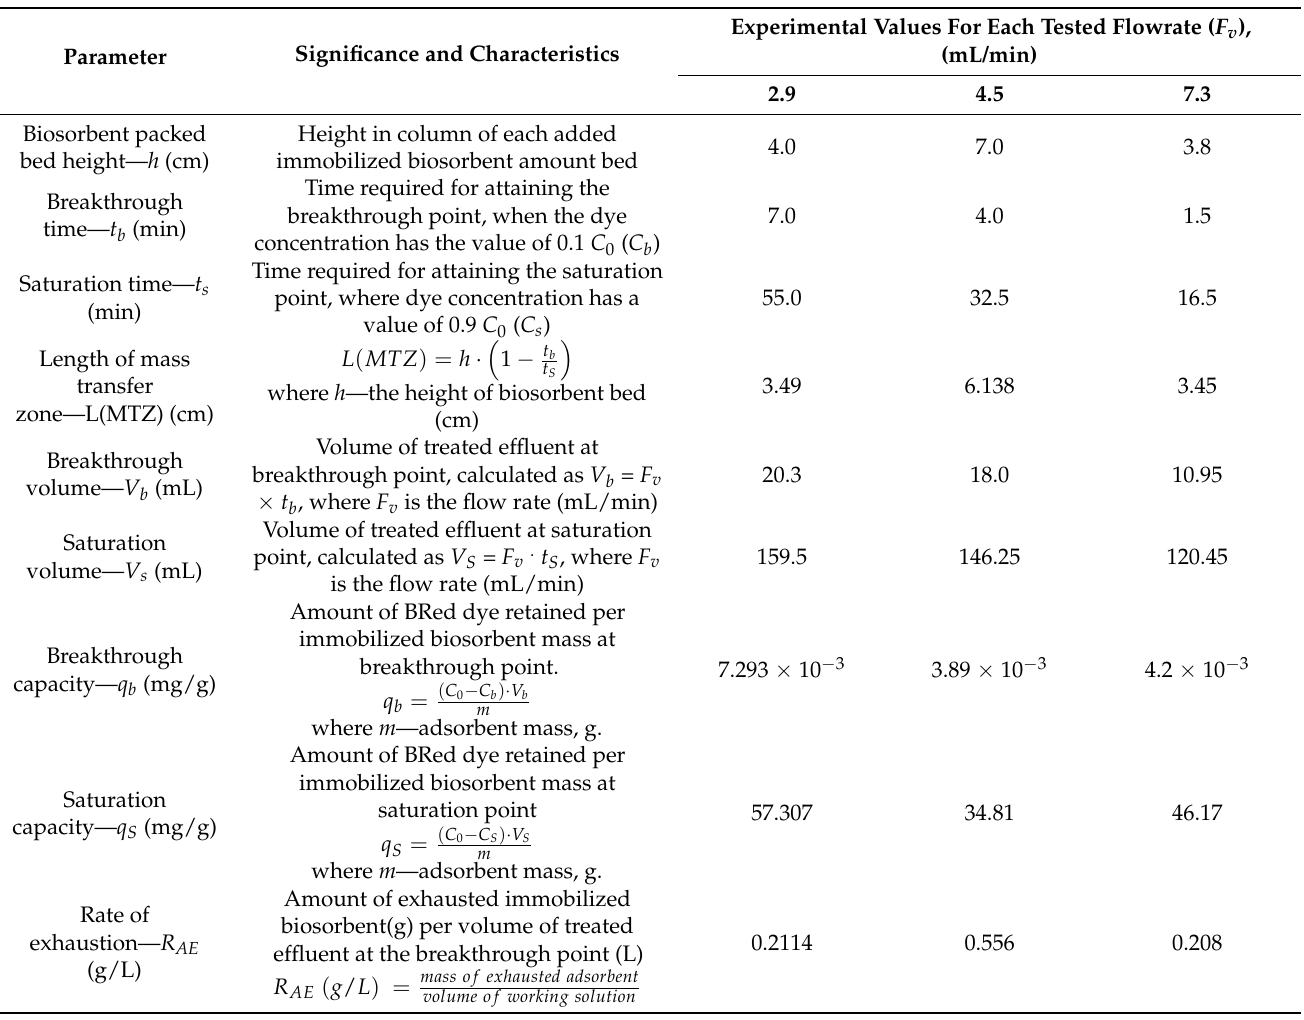
Table 2. Characteristic parameters of the breakthrough curves.